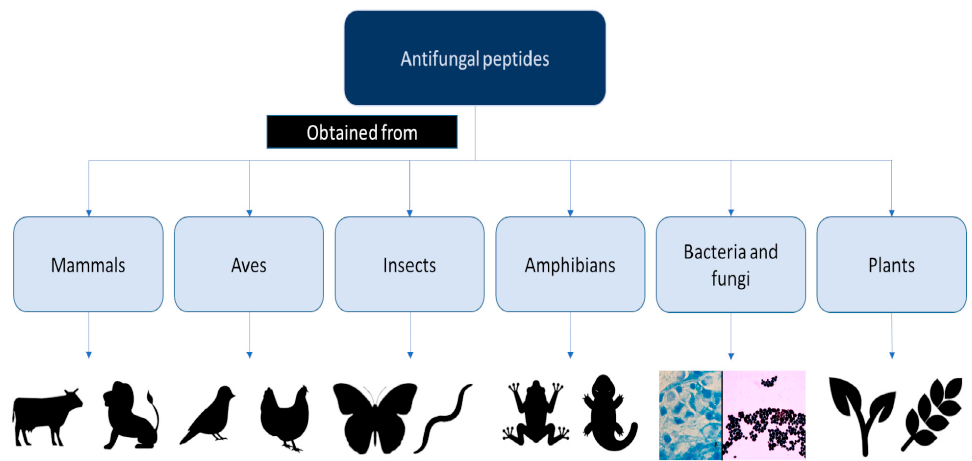
Figure 2. Drawing of the di ff erent antifungal peptide origins.